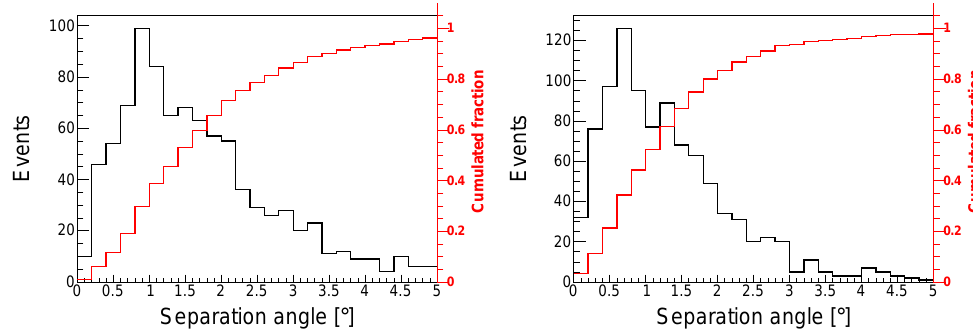
Figure 12. Performance of the angular reconstruction for UHECRs with the energy 100 EeV in the center of the field of view. ( Left ): 45 ◦ zenith angle. ( Right ): 60 ◦ zenith angle.